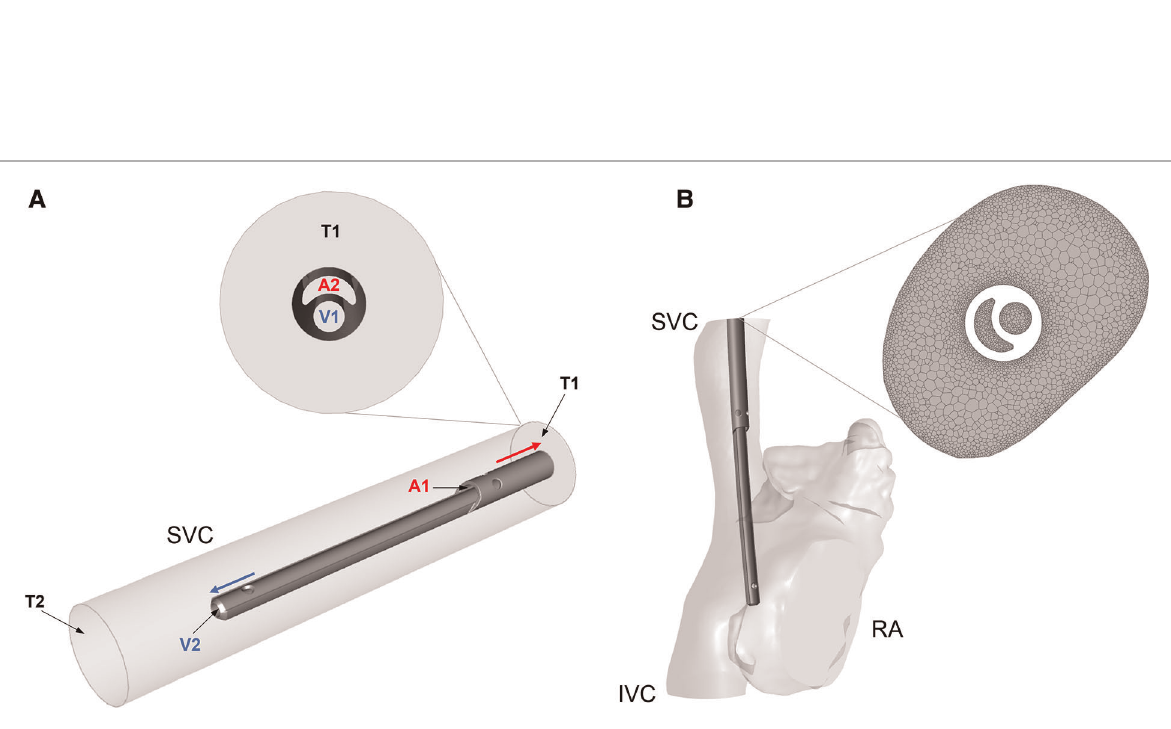
FIGURE 2 ( A ) Simpli fi ed cylindrical model of the SVC with the Hemo-Cath catheter coaxially placed inside; schematic of the fl ow directions is shown in the ideal model with a close-up at the inlet of the model. V1 and V2 are the venous inlet and outlet, A1 and A2 are the arterial inlet and outlet, T1 and T2 are the SVC inlet and outlet. ( B ) Anatomical model of RA, SVC and IVC after CVL placement. On the right-hand side, a close-up of the mesh is shown. SVC= Superior vena cava; RA=Right atrium; IVC=Inferior vena cava.